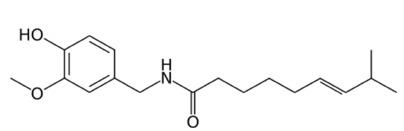
Capsaicin molecular structure, C18H27NO3. C, carbon, H; hydrogen; N, nitrogen; O, oxygen.